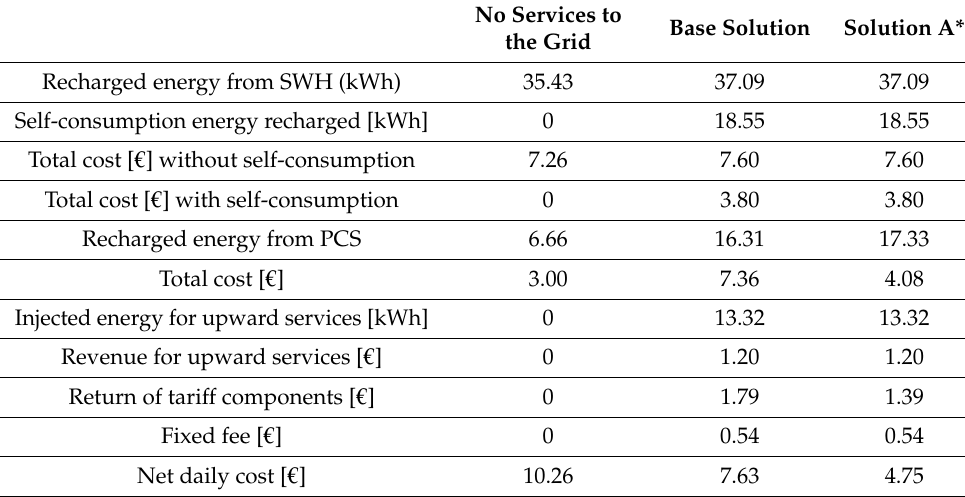
Table 31. Results for mobility pattern 3—UVAM (Scenario